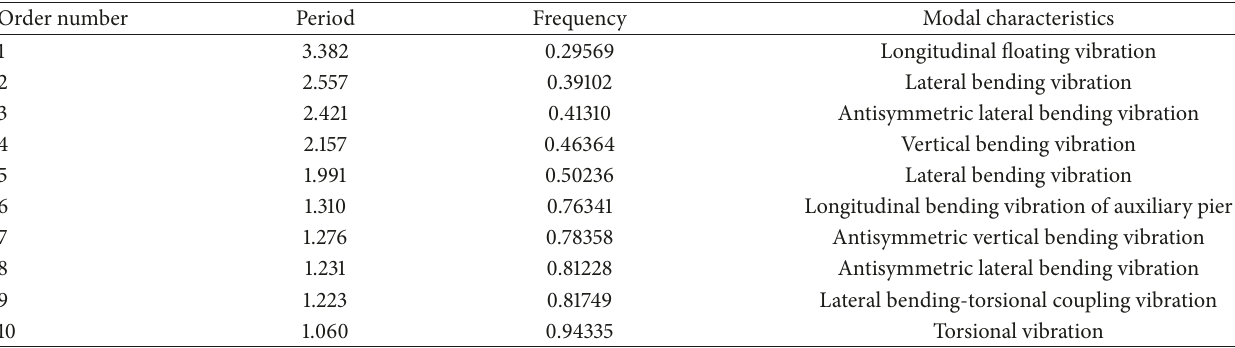
Table 4: Natural frequencies and modal characteristics.